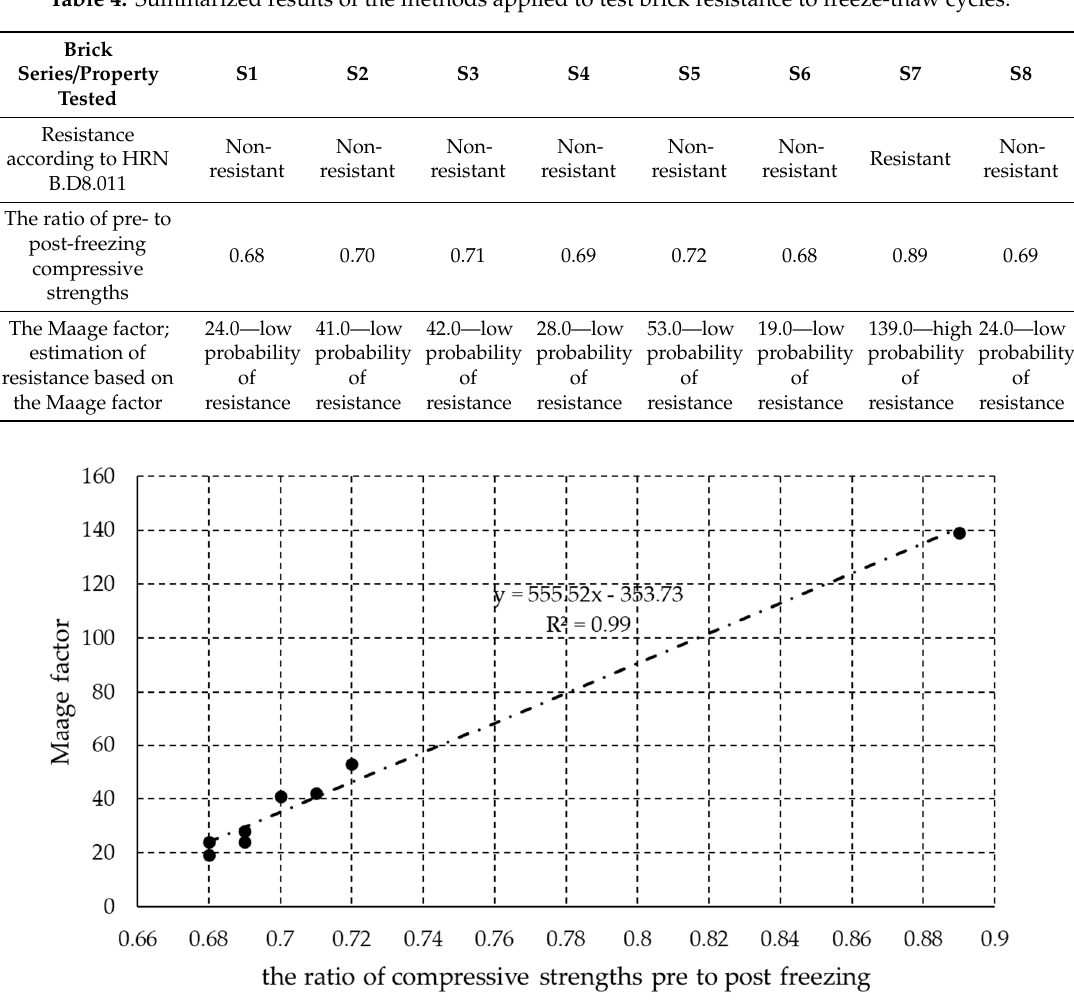
Figure 4. Correlation between the Maage factor and the ratio of pre- to post-freezing compressive strengths.